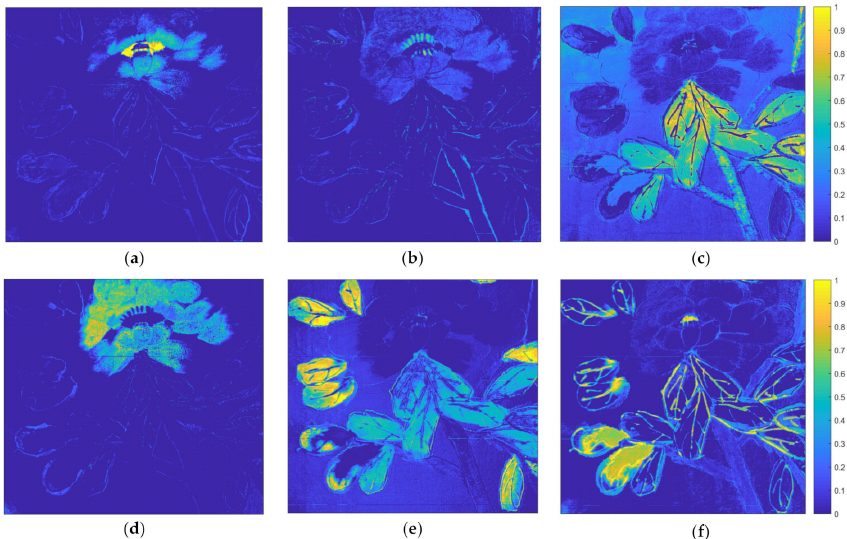
Figure 9. Abundance maps of different pigment endmembers for the Chinese painting: ( a ) abundance map of eosin; ( b ) abundance map of orpiment; ( c ) abundance map of malachite; ( d ) abundance map of vermilion; ( e ) abundance map of azurite; ( f ) abundance map of